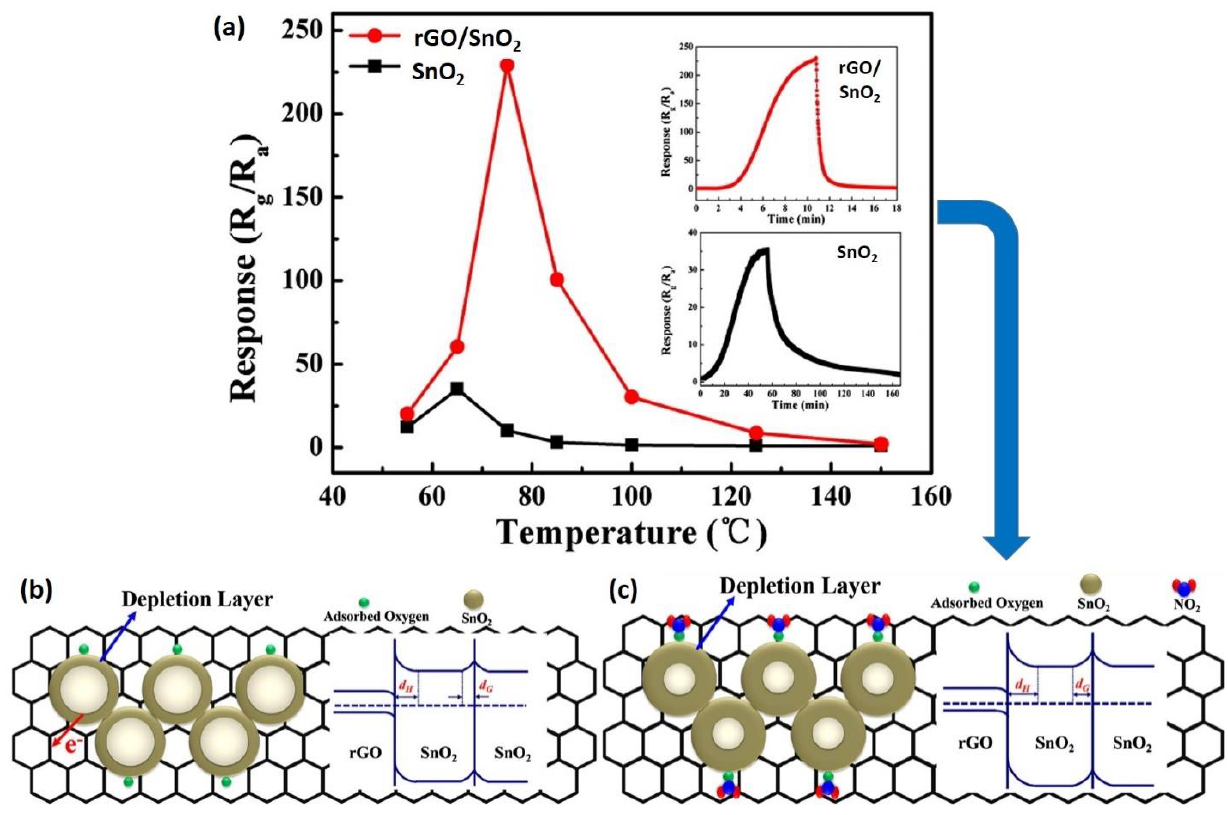
Figure 7. ( a ) The rGO/SnO 2 response towards NO 2 at 75 °C. Schematic diagram of the energy bandgap model for the sensing mechanism of the SnO 2 /rGO nanocomposite-based NO 2 sensor under ( b ) air conditions and ( c ) NO 2 atmosphere. Reproduced from ref. [143].